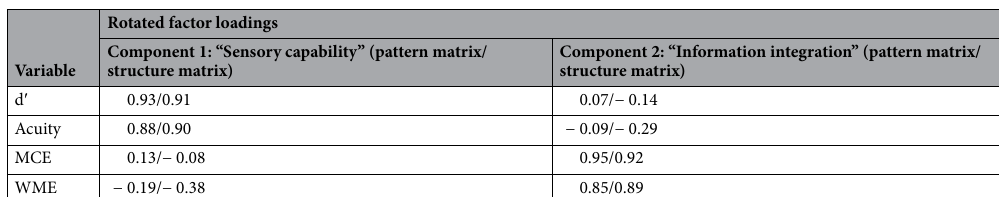
Table 2. Summary of the exploratory factor analysis. Results from oblique rotation (Oblimin with Kaiser Normalization) for the pattern and the structure matrix are shown. The four variables were resolved in two dimensions, labelled “sensory capability” and “information integration”.